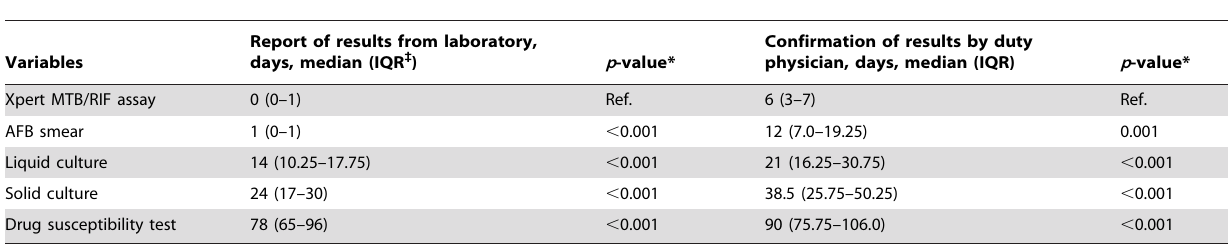
Table 5. Turnaround time of the Xpert MTB/RIF, AFB smear, liquid/solid culture and drug susceptibility test.